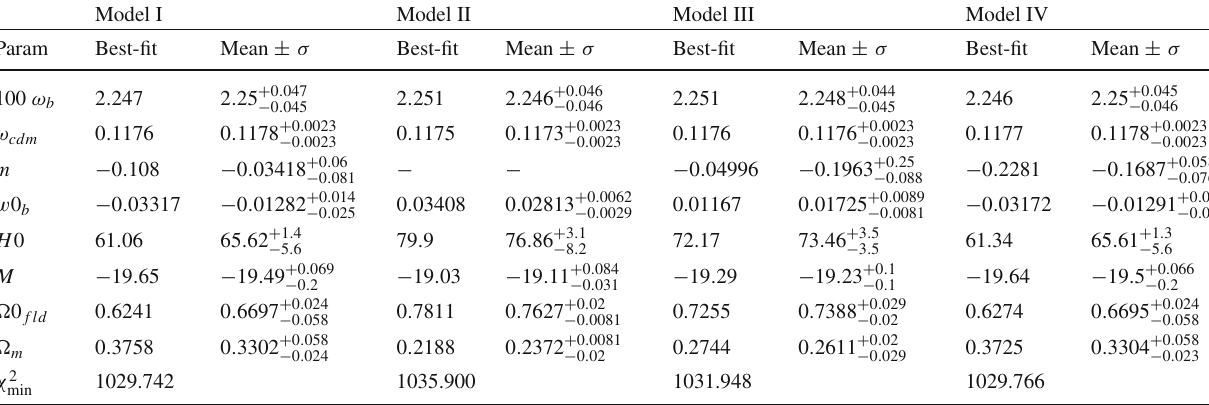
Table 1 Best fit values of model parameters for the different models using data set I (Pantheon + BAO) Model